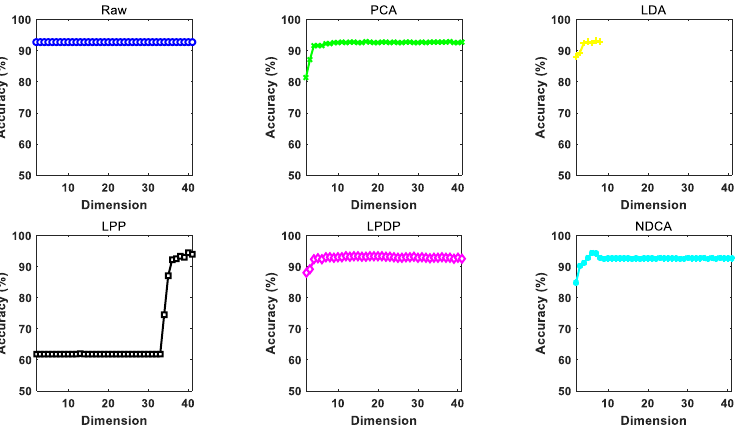
Figure 9. The performance of different dimension reduction methods under different reduced dimensions using ELM as the classifier.